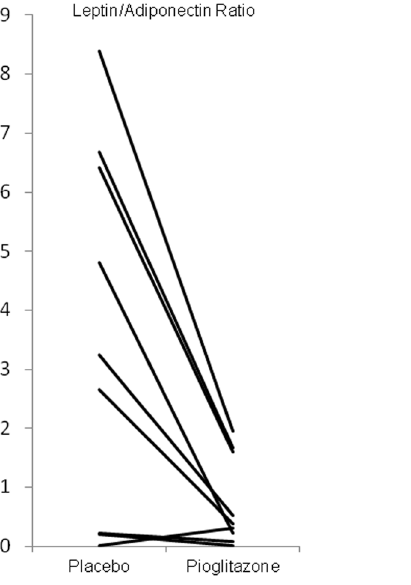
Figure 2. Individual changes in the leptin/adiponectin ratio.